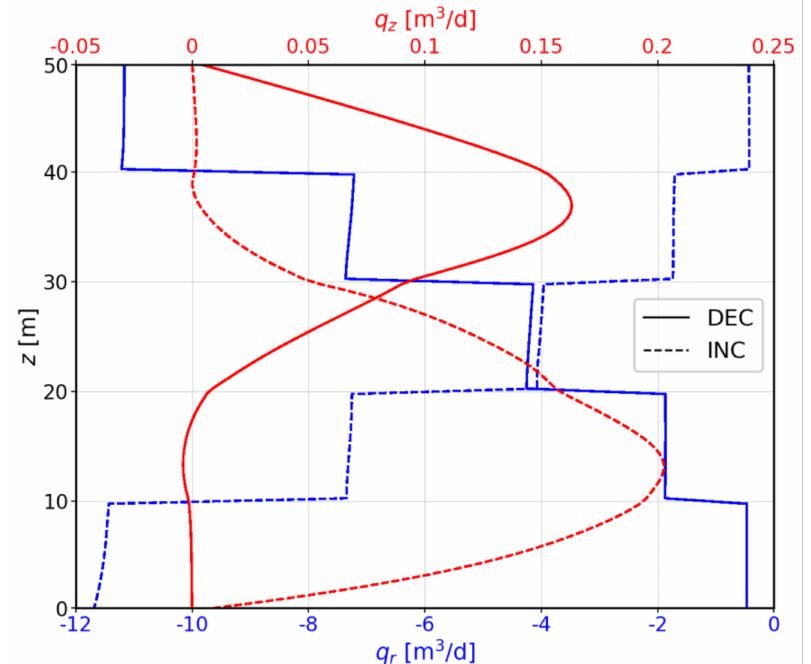
Figure 5. Flow in the horizontal direction q r (blue) and vertical direction q z (red), for the heteroge- neous cases ‘DEC’ (solid lines) and ‘INC’ (dashed lines). Results are assessed at r = 20 m that is approximately the average location of the fresh-saline interface.